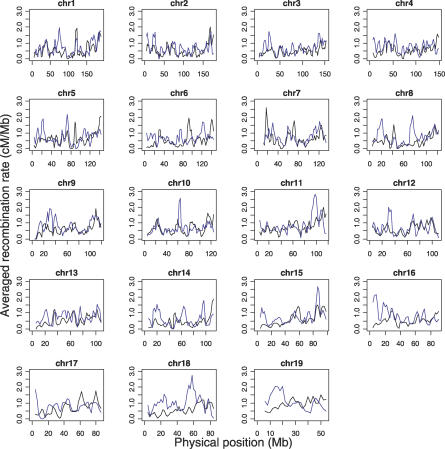
Sex-Specific Recombination Rates in the HSAverage recombination rate for all chromosomes calculated similar to the HS sex-averaged map, for males (black line) and females (blue line).